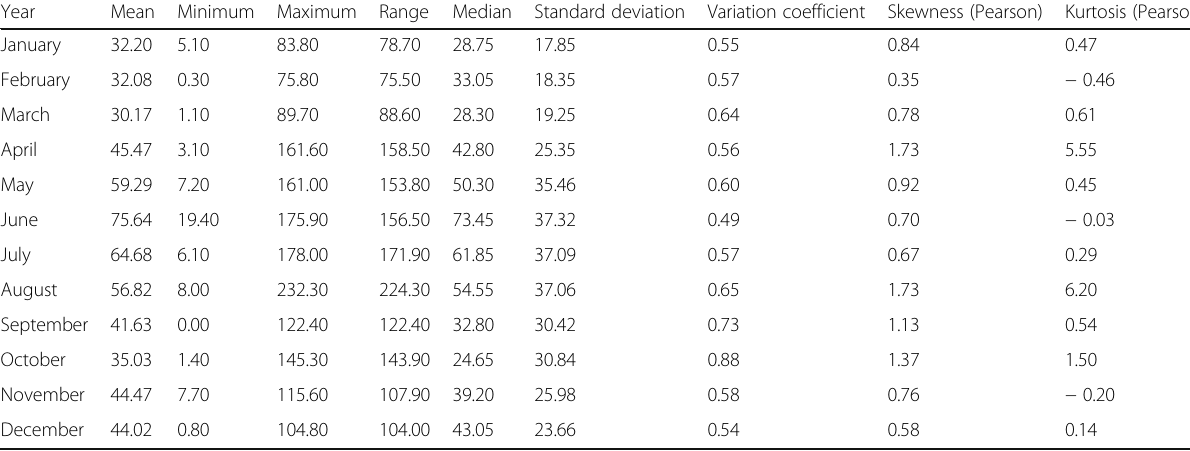
Table 2 The statistical analysis for monthly rainfall from 1951 to